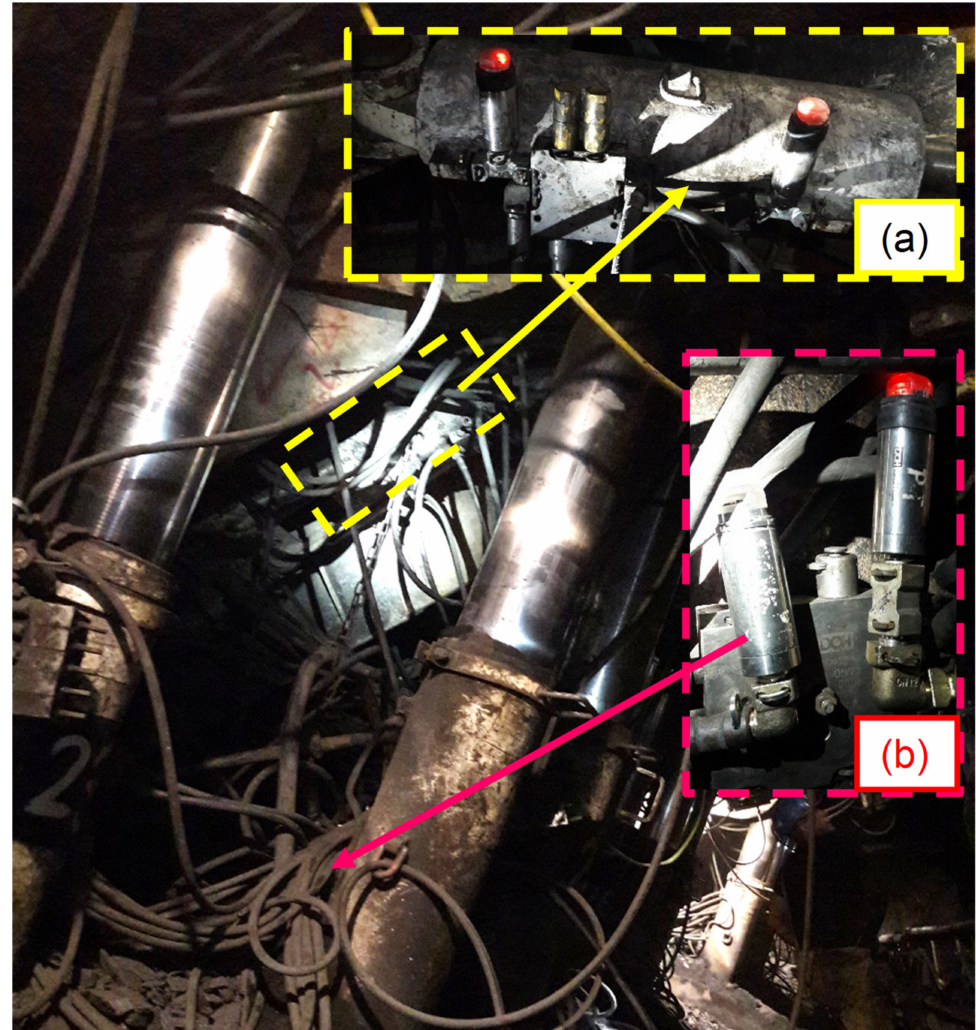
Figure 5. View of the arrangement of measurement sensors: (a) sensors placed in the actuator of the ceiling support and (b) sensors placed in the hydraulic